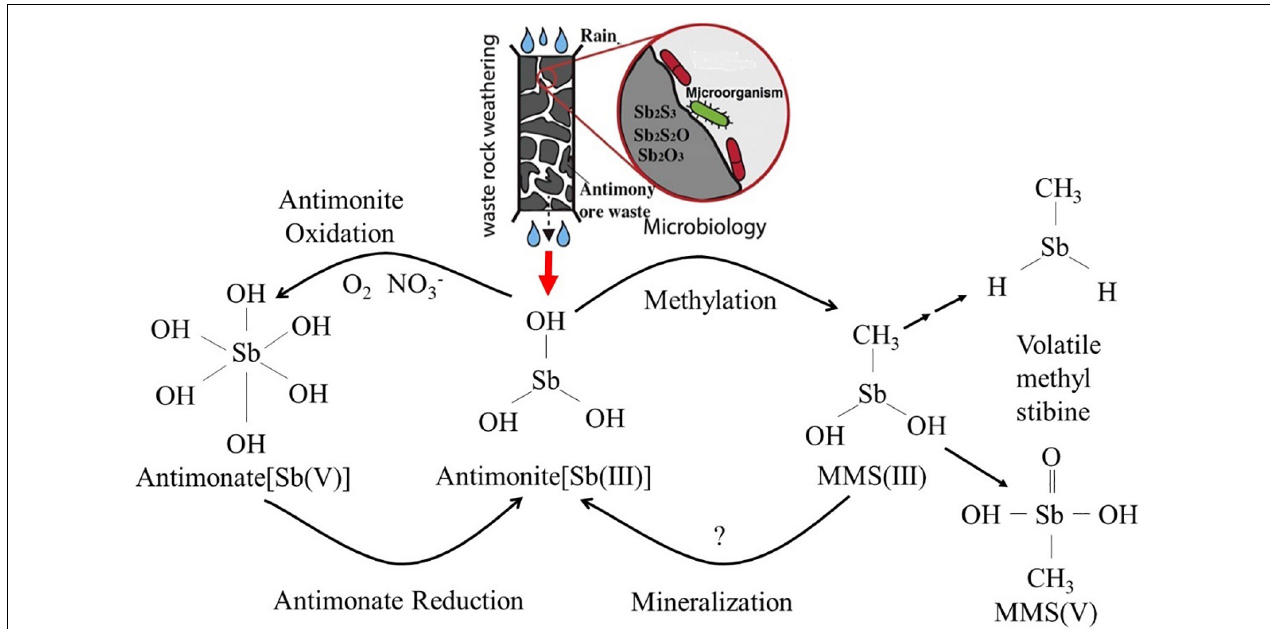
FIGURE 1 | The biotransformation relationship among the various forms in Sb biogeochemical cycling (Li,